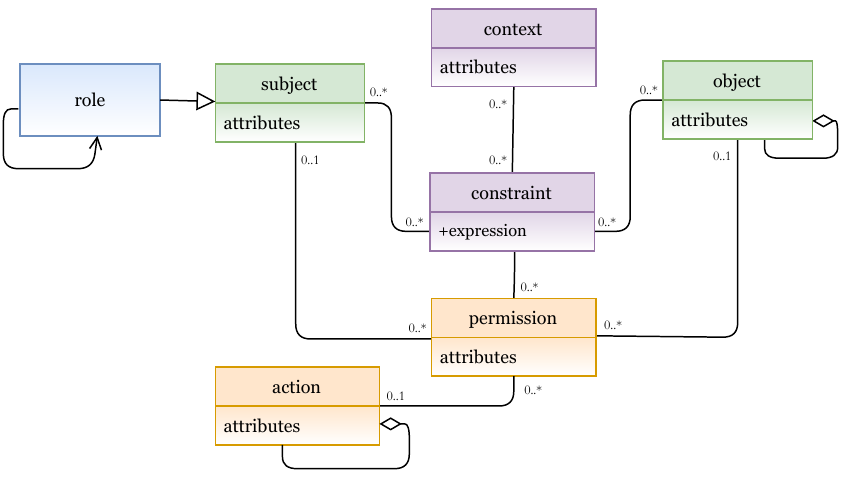
Figure 16. Hybrid RBAC/ABAC model.